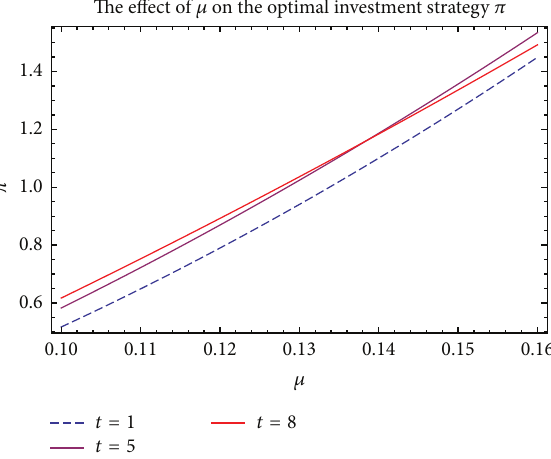
Figure 2: The optimal investment strategy increases with the appreciation rate 𝜇 of risky